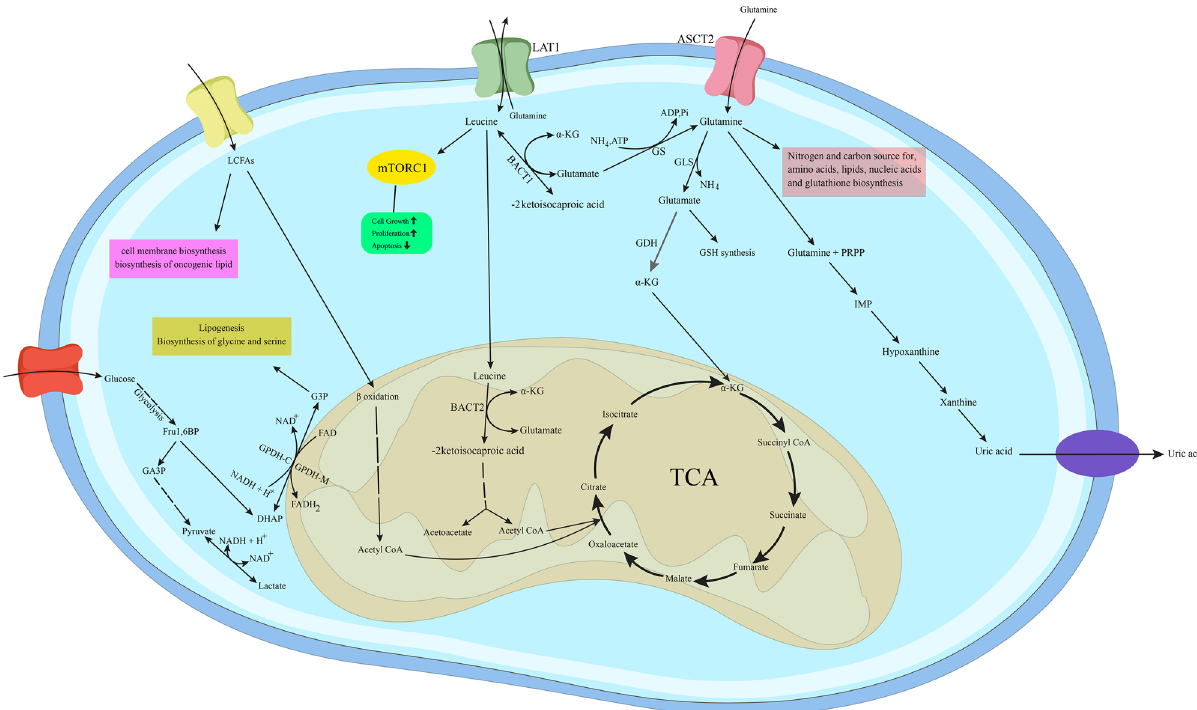
Figure 4. Metabolic reprogramming in MTC. The most crucial metabolic reprogramming in MTC tumorigenesis are leucine and glutamine metabolism, purine catabolism, and G3P shuttle. TCA tricarboxylic acid, α-KG α-ketoglutarate, LAT1/SLC7A5 L-type AA transporter, ASCT2/SLC1A5 alanine-serine-cysteine transporter2, BCAT1 cytosolic branched-chain aminotransferase, BCAT2 mitochondrial branched-chain aminotransferase, mTORC1 mammalian targets rapamycin complex 1, GS Glutamine synthetase, GDH glutamate dehydrogenase, ALT alanine transaminase, AST aspartate transaminase, GLS glutaminase, LCFAs long-chain fatty acids, G3P glycerol-3-phosphate, DHAP dihydroxyacetone phosphate, GSH glutathione, PRPP phosphoribosyl pyrophosphate, IMP inosine